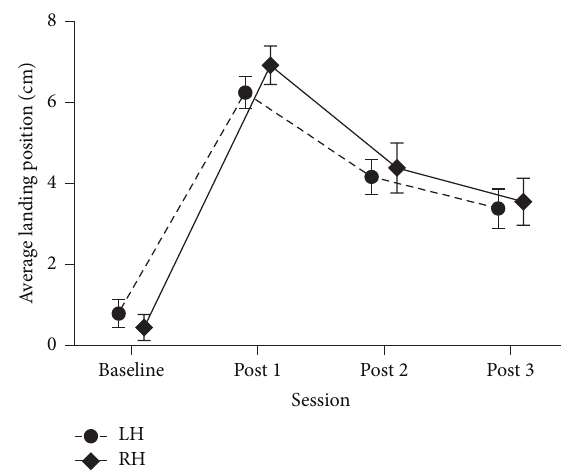
Figure 1: Average landing position for the open-loop pointing measureatbaseline,post1(immediateafterLPA),post2(20minutes after LPA), and post 3 (45 minutes after PA) ( 𝑛 = 14 for each stimulated hemisphere group). Average landing position ( 𝑦 -axis) is represented in centimeters and bars represent standard errors of the mean (SEM).